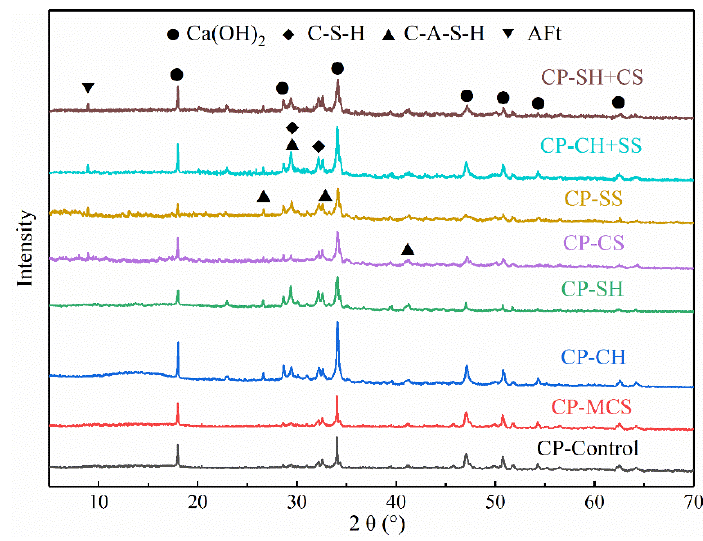
Figure 6. XRD patterns of cement pastes.